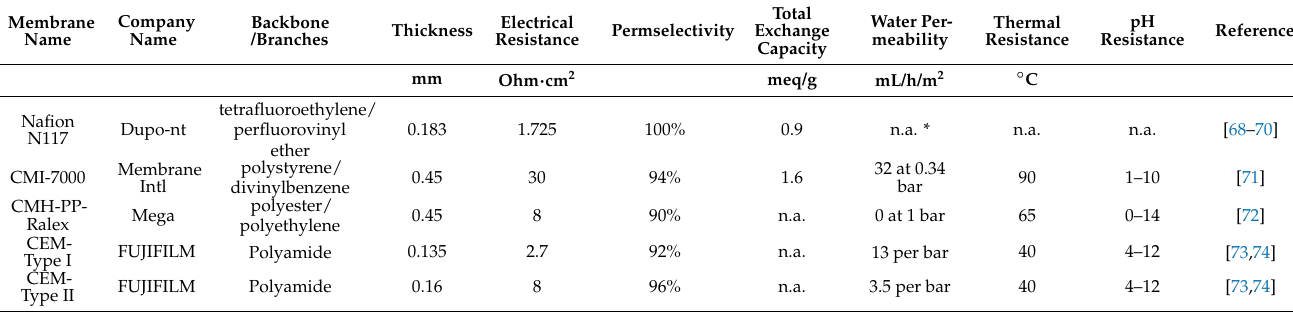
Table 1. Properties of commercial cation exchange